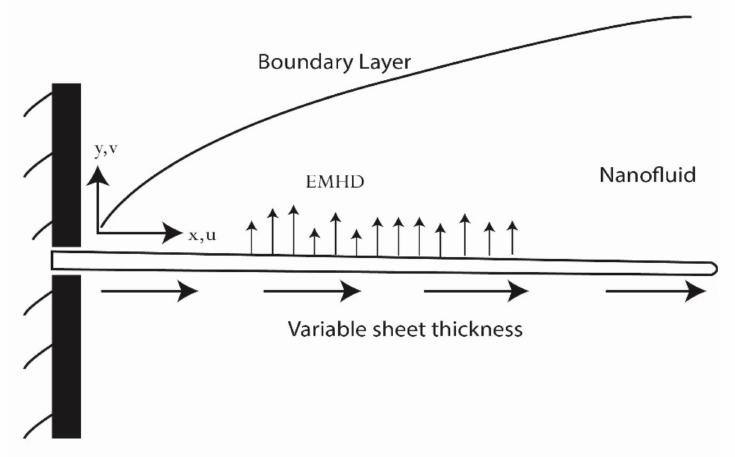
Figure 1. Schematic diagram of the